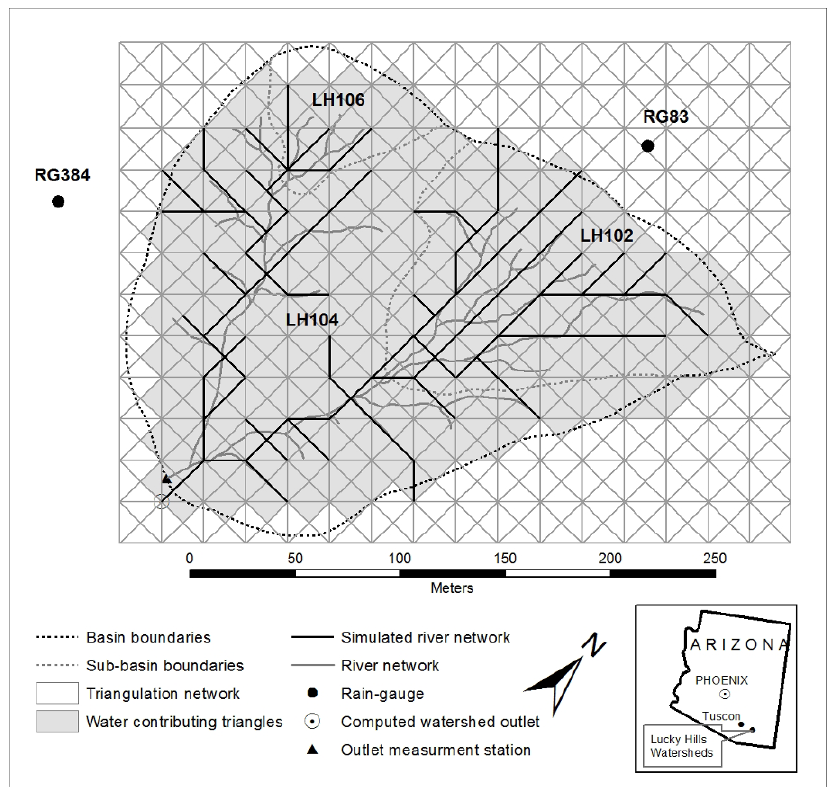
Figure 1. The Lucky Hills watersheds and their semi-TIN based simulation (grey filled triangles). The natural river network is represented by the curved grey lines and the simulated by the straight black